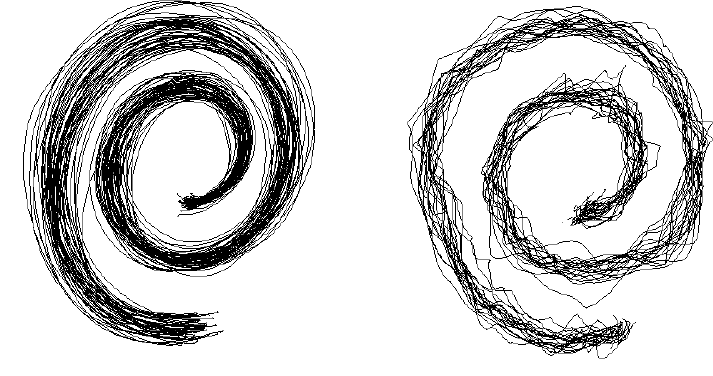
Figure 1. Superimposition of spirals drawn on a digitized tablet. Left panel: control subject, right panel: patient with tremor - the spirals are irregular with